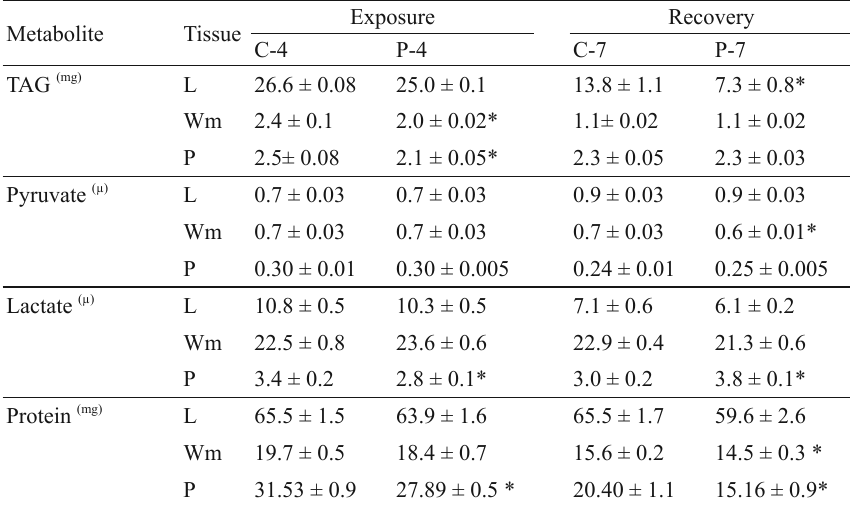
Metabolites concentrations are expressed in μ mol ( μ ) or mg (mg) per g of tissue or per mL of plasma. C-4 control of exposure for 4 days; P-4 exposed for 4 days; C-7 control of recovery; P-7 recovered for 7days; L = liver; Wm = white muscle; P = plasma; FFA = free-fatty acids; TAG = triacylglycerol; Values are followed by mean ± SE (*) difference between the exposed group and the corresponding control is signi fi cant at P <0.05 ( n =12).